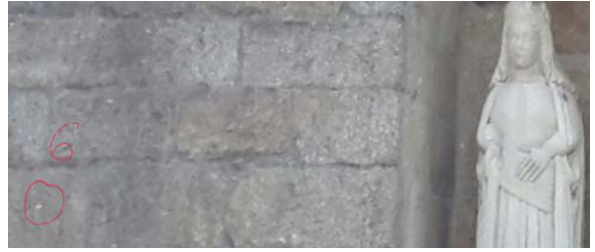
Figure 5. Natural target nº 6: white dot on the granite